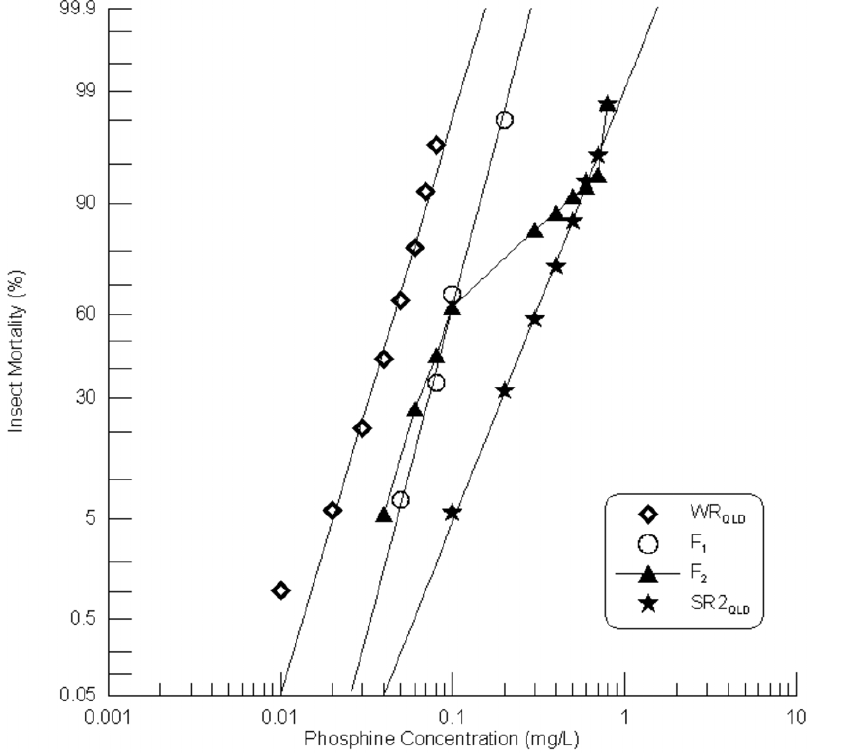
Figure 1. Resistance response of F 1 hybrids and F 2 progeny of a cross between a weakly resistant and a strongly resistant R. dominica strain from Queensland. Results are presented as log-dose mortality of the F 1 hybrids and the F 2 progeny with reference curves of the parental strains, WR QLD (Weak R-Strain) and SR2 QLD (R-Strain). Phosphine exposure was for 48 hours at 25 u C and 70% r.h.